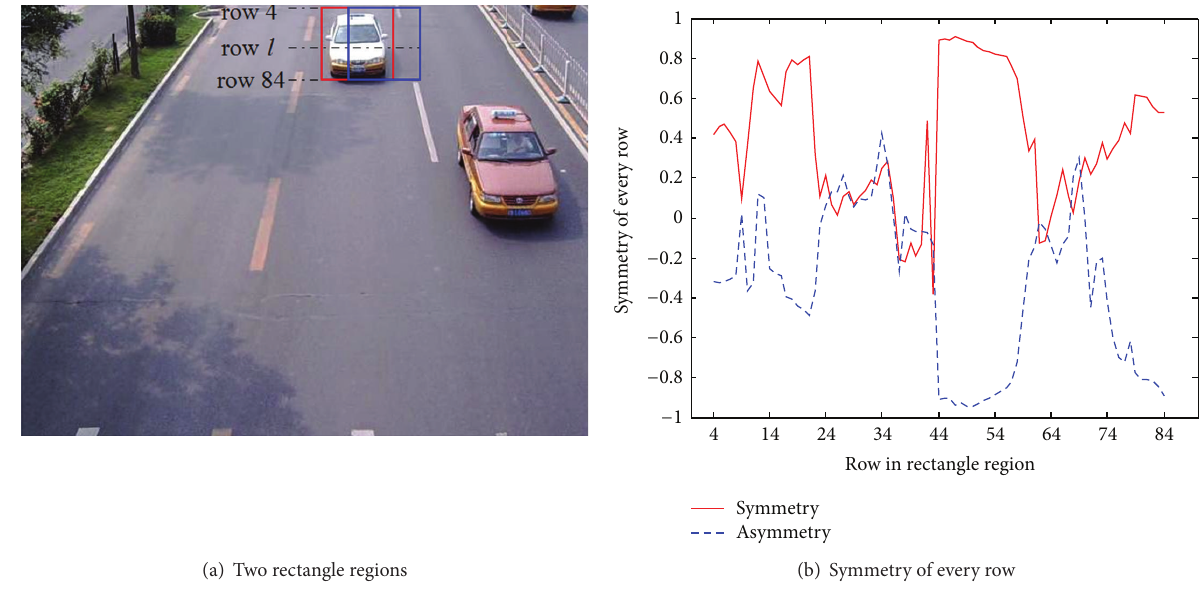
Figure 1: Example of symmetry